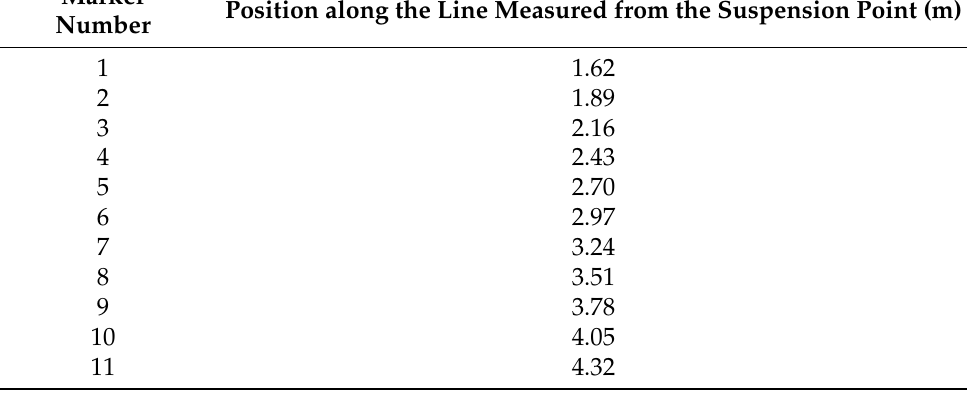
Table 4. Position of the red marks used for capturing the line movements.